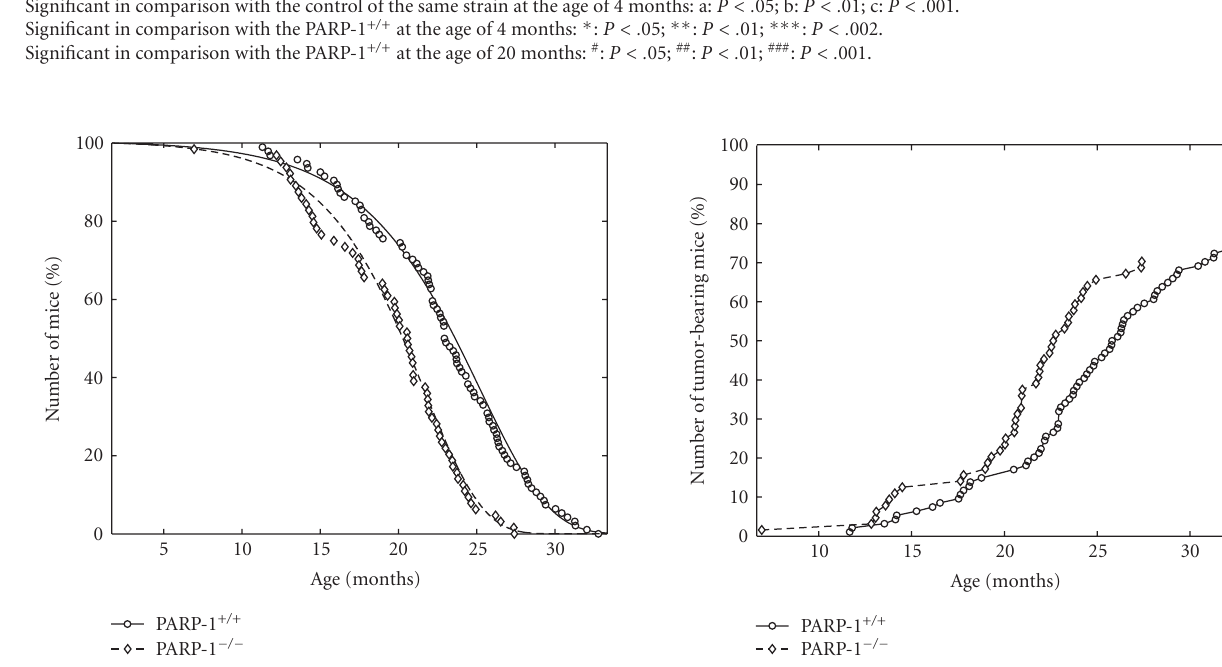
Figure 7: Empirical and approximated by Gompertz model survival curves of PARP-1 − / − and PARP-1 + / + mice. Surviving mice in each group were presented as percentage as a function of age.